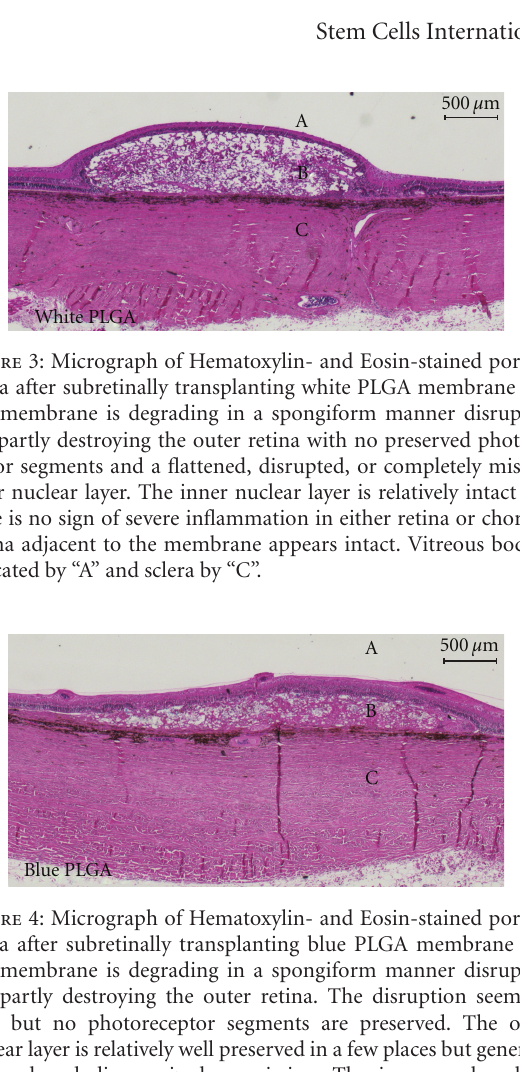
Figure 4: Micrograph of Hematoxylin- and Eosin-stained porcine retina after subretinally transplanting blue PLGA membrane (B). The membrane is degrading in a spongiform manner disrupting and partly destroying the outer retina. The disruption seems to vary, but no photoreceptor segments are preserved. The outer nuclear layer is relatively well preserved in a few places but generally flattened and disorganized or missing. The inner nuclear layer is relatively intact. No sign of severe inflammation in retina or choroid. Retina adjacent to the membrane appears intact. Vitreous body is indicated by “A” and sclera by